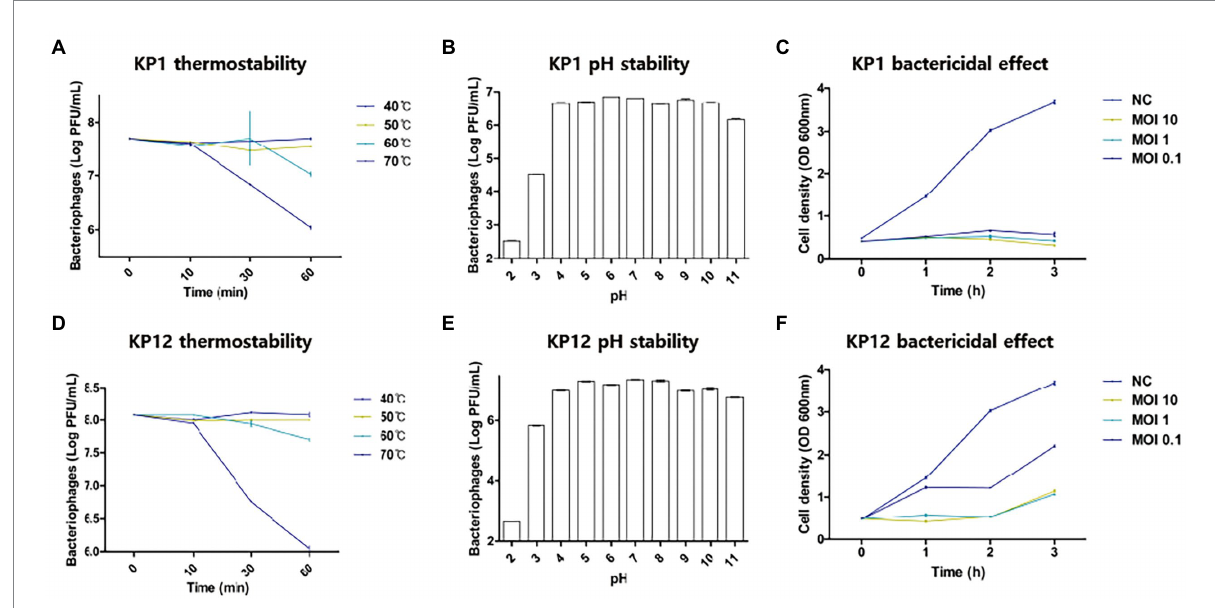
FIGURE 2 Physiological properties of KP1 and KP12. Effects of temperature, pH on the phage titer, and the phage bactericidal effects at different MOI levels of KP1 (A–C) and KP12 (D–F) . Thermostability of phages was tested in the range of 40 ° C–70 ° C for 60 min, and pH stability of phages was tested in the range of pH 2–11. To validate the bactericidal effect of each phage, bacteria were infected by KP1 and KP12 bacteriophage with MOIs of 10, 1, 0.1. Negative control (NC) was a bacteria-only culture media. Bacterial cell density on the phage titer with different MOI level was measured at 1-h intervals.